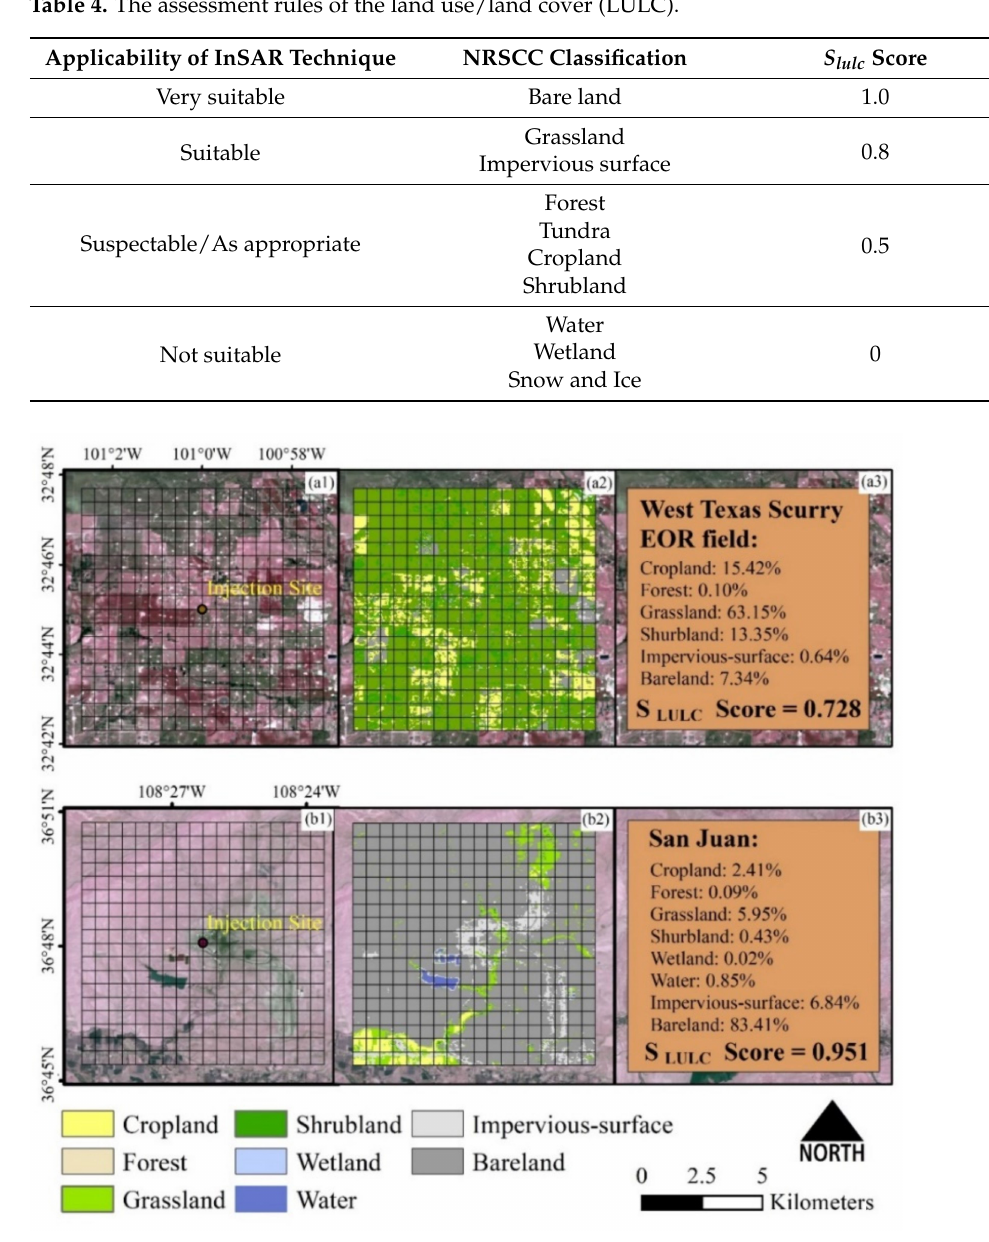
Figure 4. The graphs show the LULC of Scurry and San Juan. The base map is the true color composite image of LANDSAT 8 OLI. ( a1 , b1 ) show the location of the injection wells and their buffers in the study area. ( a2 , b2 ) show their LULC classification with a resolution of 30 m. ( a3 , b3 ) illustrate the proportion of the LULC classification in each study area, and the calculated S LULC